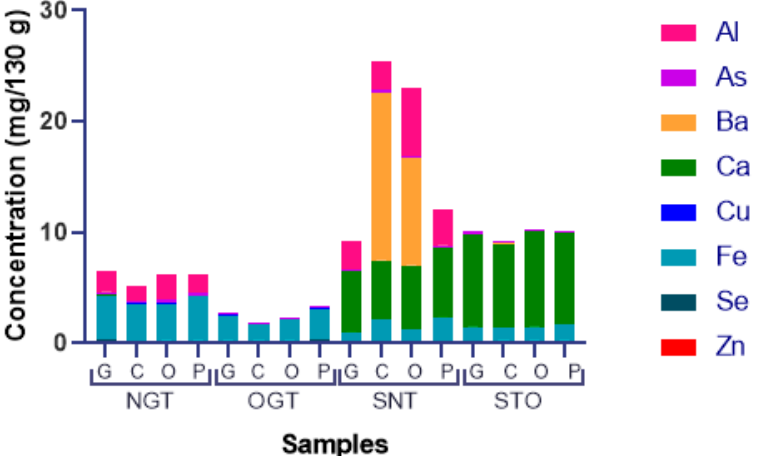
Figure 1. Elemental content distribution in canned tuna fish quantified by ICP OES. NGT = Natural Grated Tuna; OGT = Oil Grated Tuna; SNT = Solid Natural Tuna; STO = Solid Tuna in Oil. Calcium contents ranged from 0.01 ± 0.003 to 9.2 ± 2.6 mg/130 g (Table 1). Structure and solvent were the main sources (95.79%; p < 0.0001) of calcium variations in samples, with high calcium content in solid samples